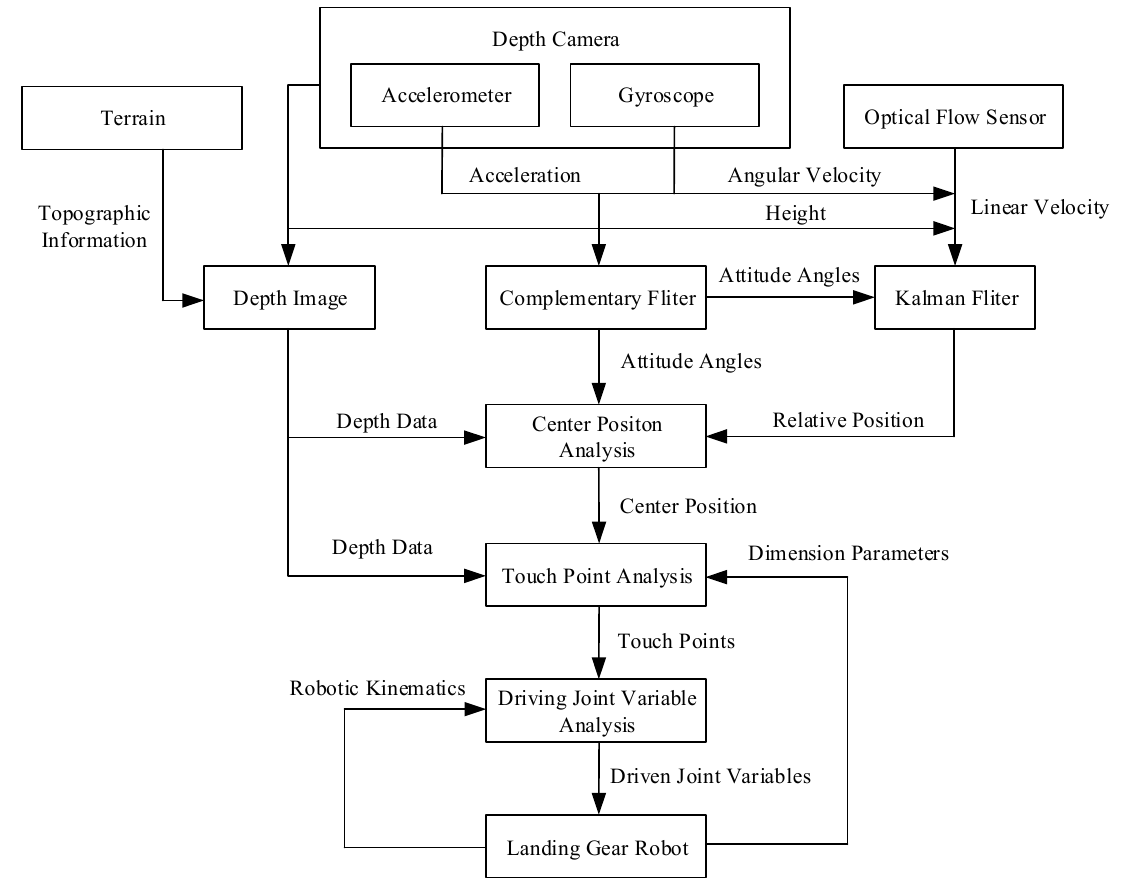
Figure 7. Flow chart of the adaptive landing control algorithm.